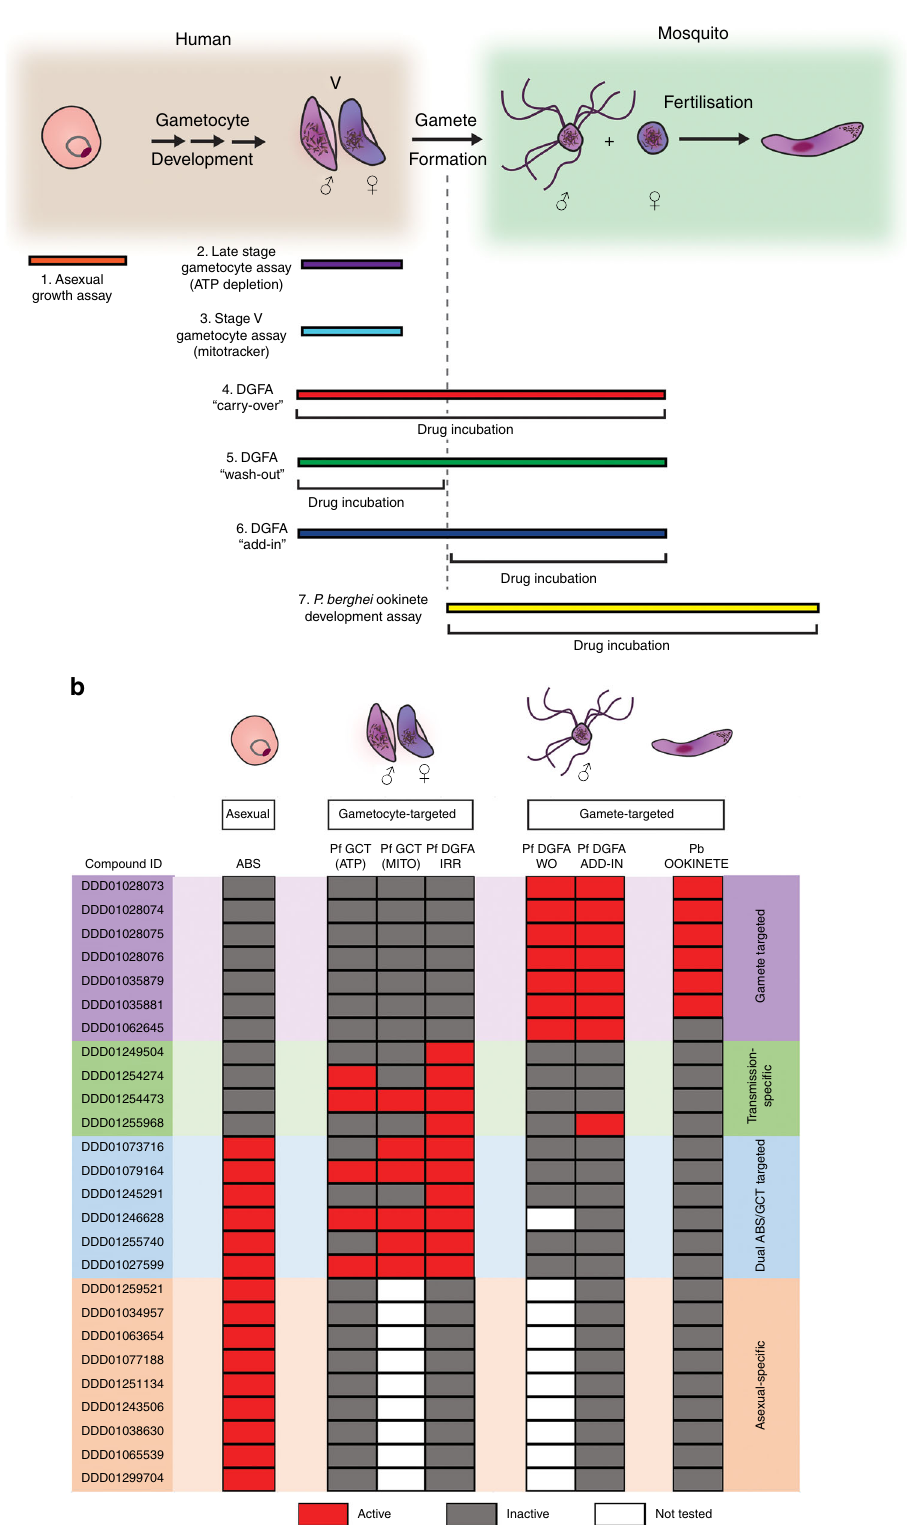
associate with the generally small condensed nucleus. At the last observed time point (20 min post induction), a proportion of cells had commenced DNA replication, possessing microtubule fi bres resembling the initial round of endomitosis of the DMSO control and an increase in DNA content (Fig. 5b). Most DDD291-treated male gametocytes also arrested after rounding up (Figs. 4f and